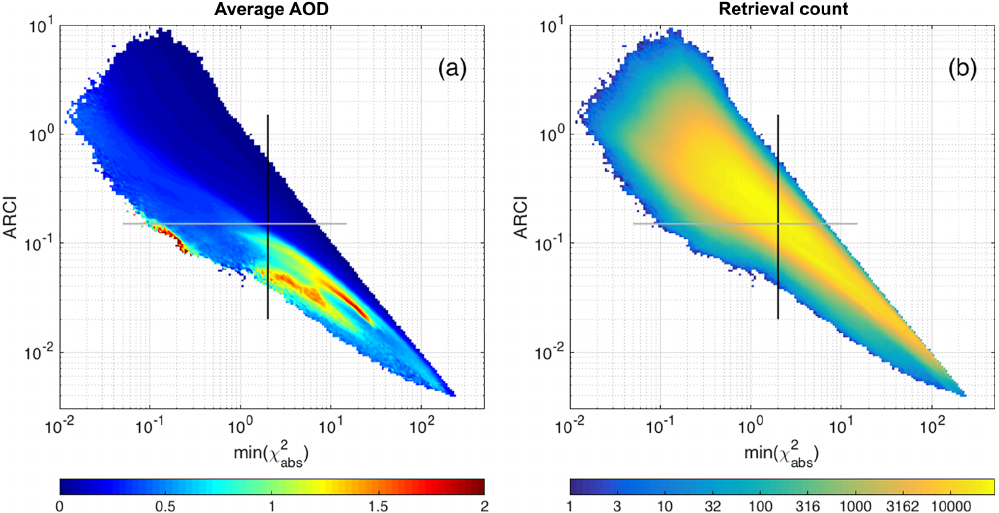
) for the combined months of January and July of 2007; (b) retrieval count abs